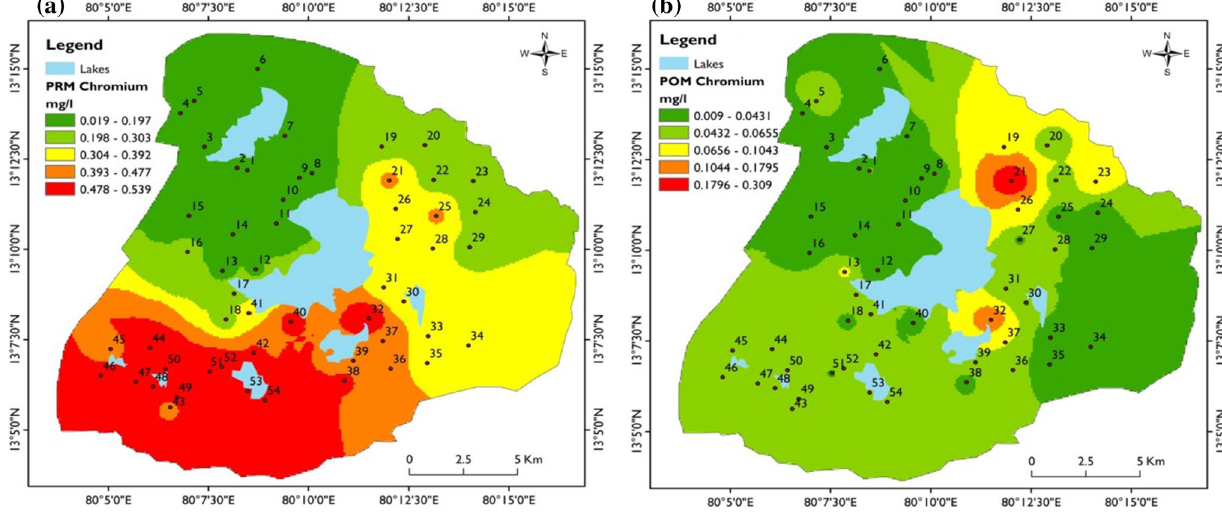
Fig. 9 a , b Spatial variation of Cr in the groundwater for pre-monsoon and post-monsoon,